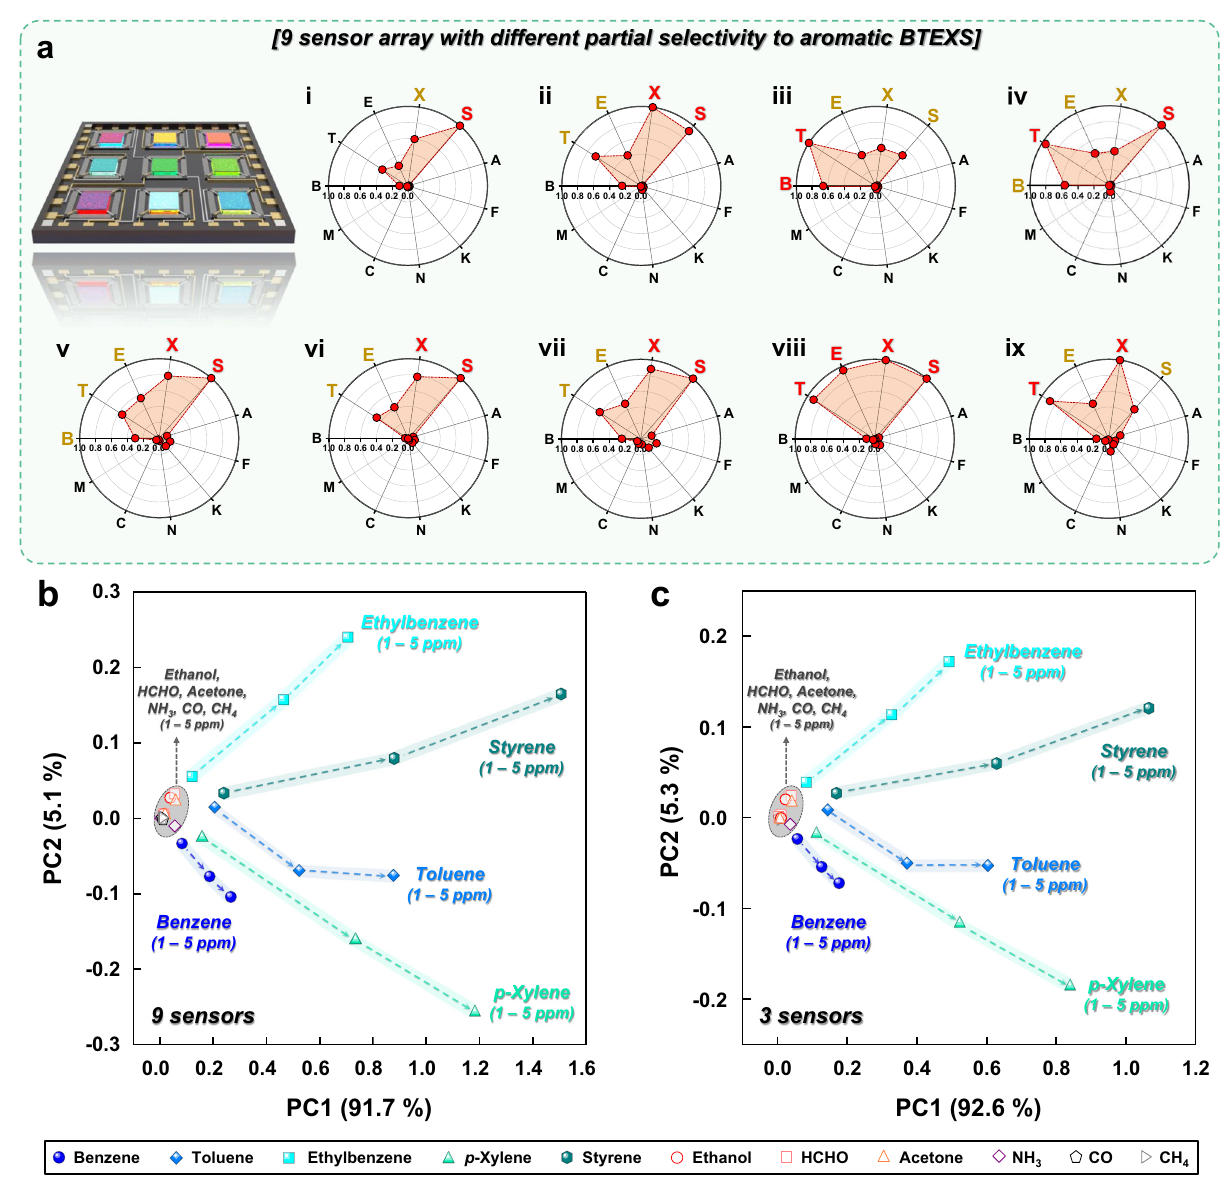
Fig. 9 | Quantitative and discriminative detection of volatile aromatic com- poundsusingbilayersensorarrays.a Polarplotsofresponsesto5ppmofanalyte gases for (i) 0.05CeO 2 /Rh – SnO 2 , (ii) 0.1CeO 2 /Rh – SnO 2 , (iii) 0.4CeO 2 /Rh – SnO 2 , (iv)0.7CeO 2 /Rh – SnO 2 ,(v)0.4CeO 2 /Au – SnO 2 ,(vi)0.4CeO 2 /Rh – In 2 O 3 ,(vii)0.4CeO 2 / Au – In 2 O 3 , (viii) 0.4CeO 2 /WO 3 , and (ix) 0.4CeO 2 /ZnO sensors (B: benzene, T:toluene,E:ethylbenzene,X: p -xylene,S:styrene,A:ethanol,F:HCHO,K:acetone,